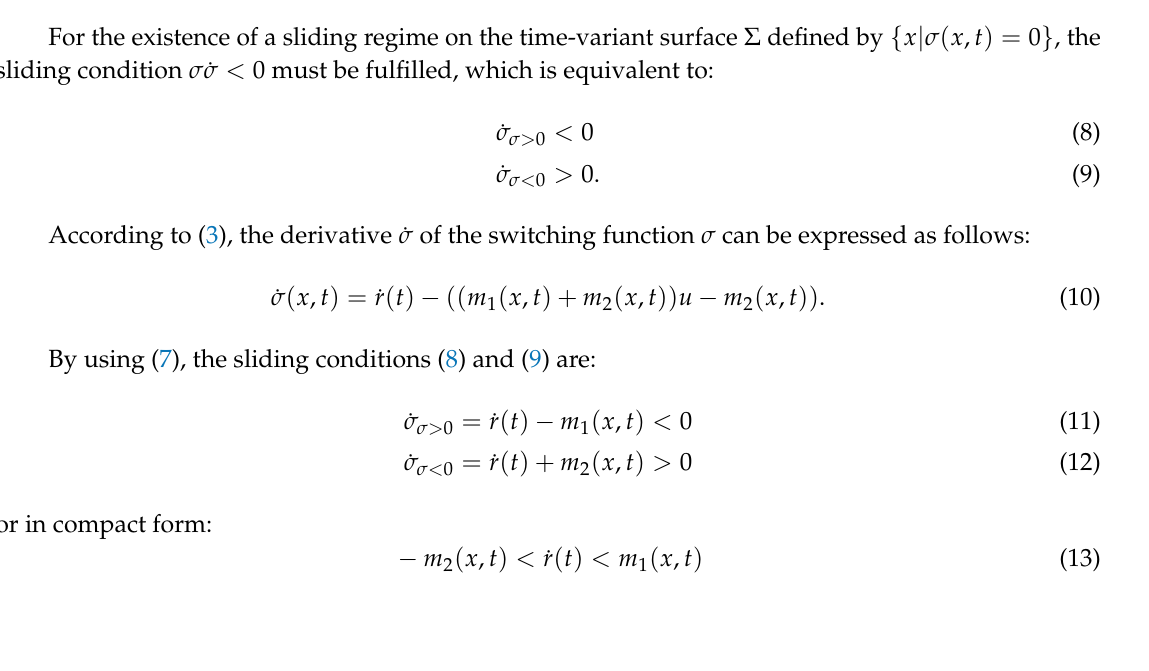
Figure 1. Simplified diagram of a DC-DC converter under Current Mode Control